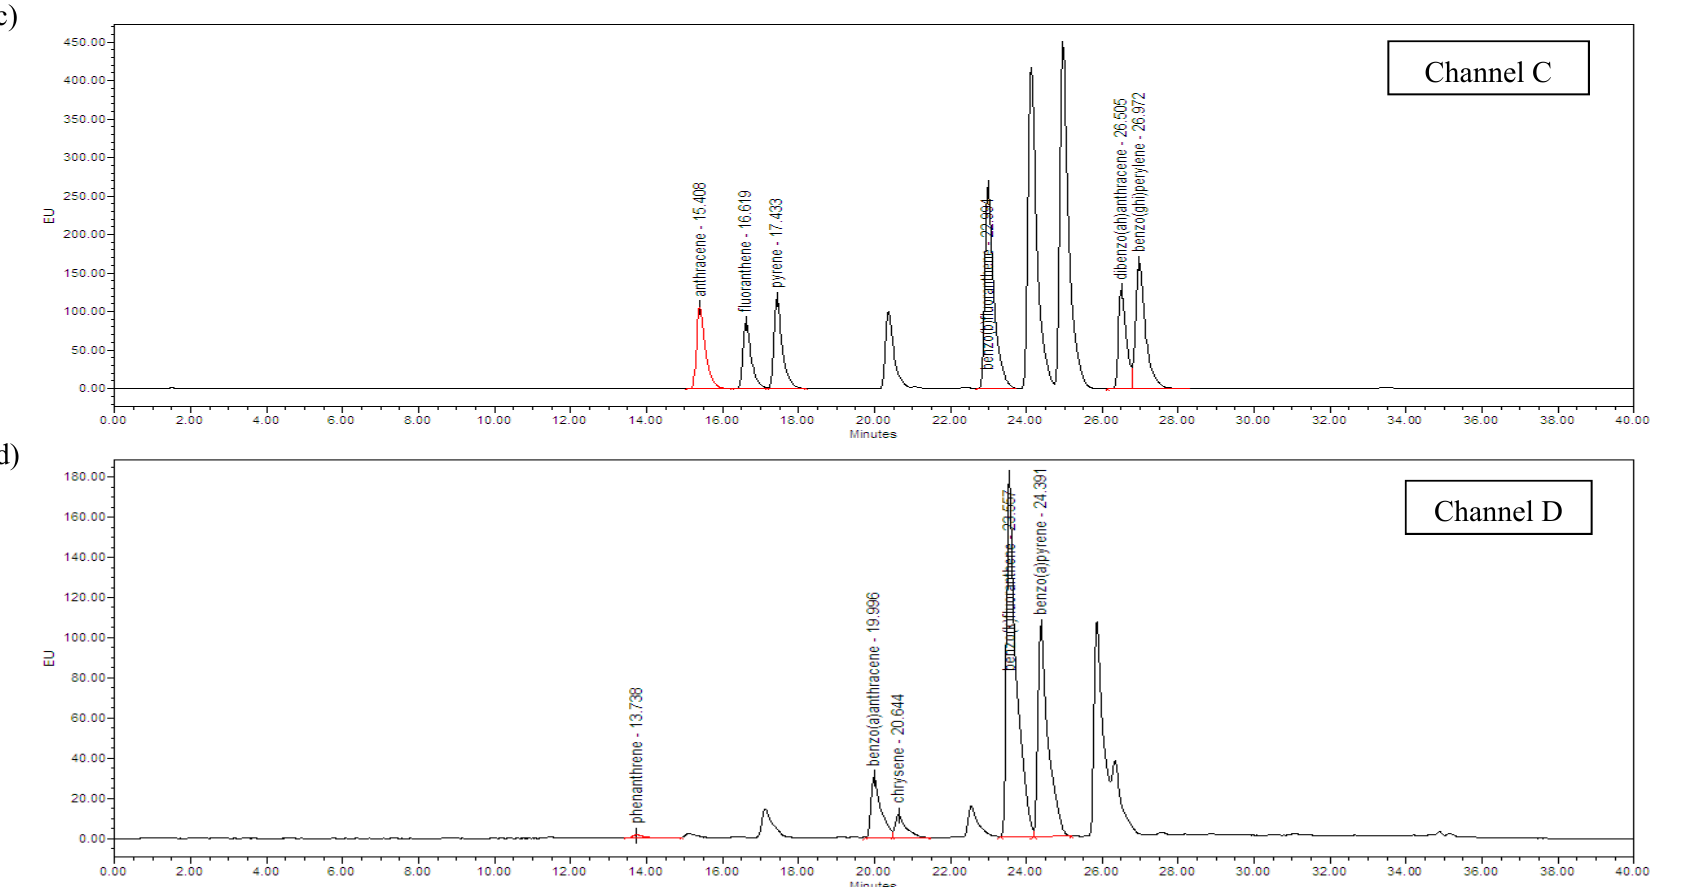
Figure 1. HPLC/UV-FLD chromatograms of PAHs’ standard mixture. The PAHs were detected at four different channels of the fluorescence detector; ( a ) Channel A: λ ex = 246 nm, λ em = 488 nm; ( b ) Channel B: λ ex = 276 nm, λ em = 330 nm; ( c ) Channel C: λ ex = 296 nm, λ em = 400 nm; ( d ) Channel D: λ ex = 340 nm, λ em = 425 nm. Red line showed the detected PAHs.